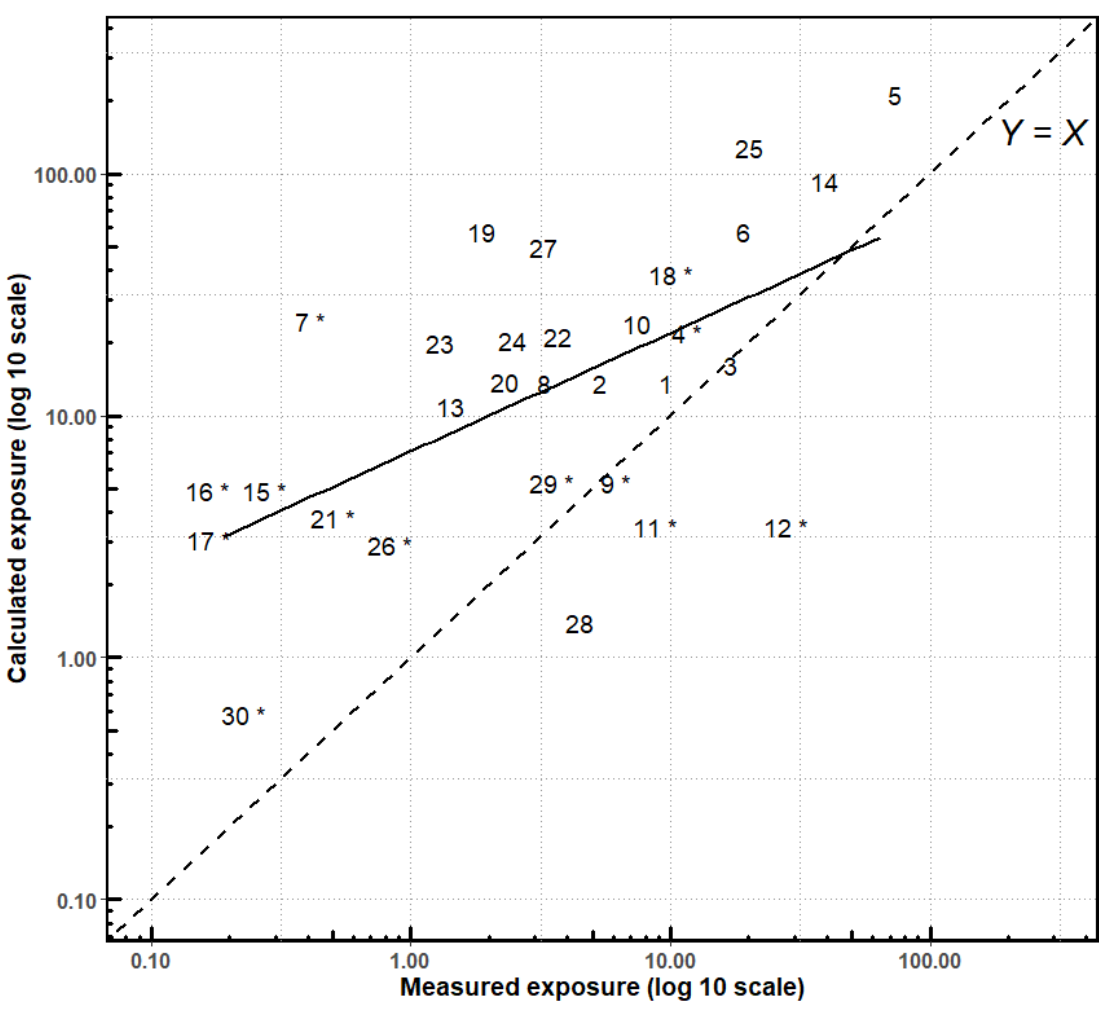
Figure 3. Linear regression of daily exposure (mg): calculated using the AOEM and measured in the CANEPA study. N = 30. Correlation: r (Pearson coefficient) = 0.76, p -value < 0.0001. Regression: R 2 = 0.58. Missing values for head exposure were considered to be zero. Each number corresponds to one observation. * Observations in which dithianon was applied; the others correspond to the application of captan.